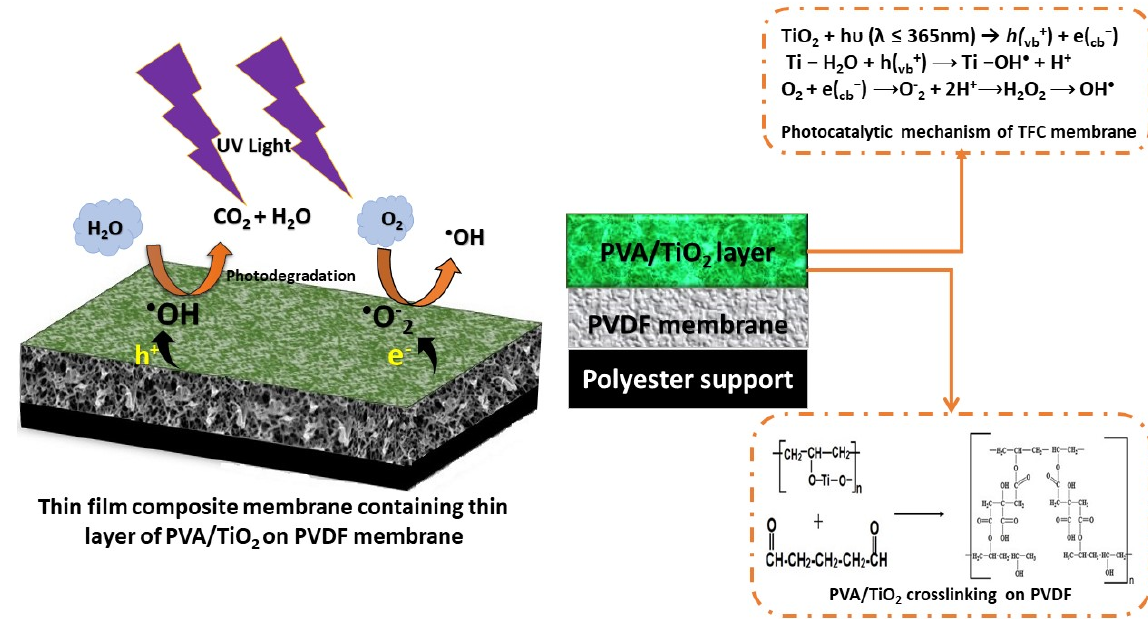
Figure 9. Photocatalytic mechanism of TFC membrane under UV